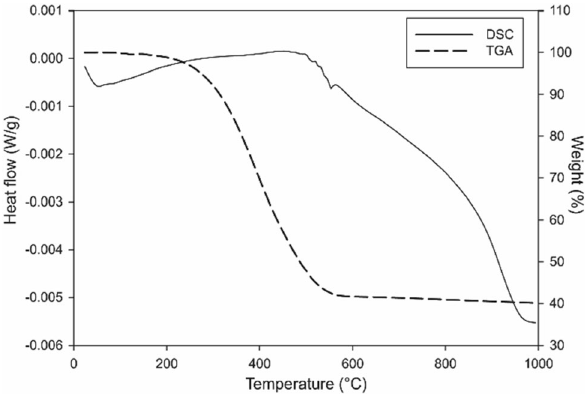
Fig. 2 XRD results for CTP sample and obtained solids at different working